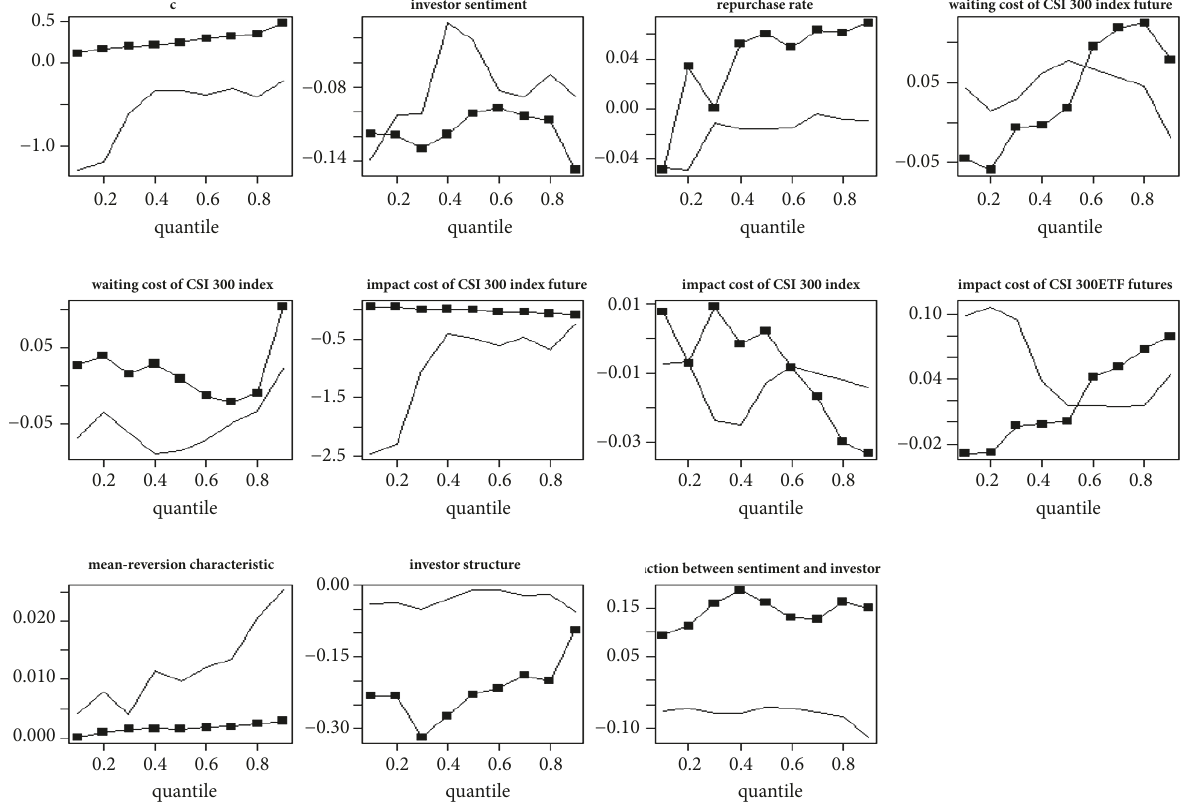
Figure 1: Changes of the quantile regression coefficients of the influence factors of the basis. Note: the solid line with square dots represents the quantile regression results in the chaotic stock market, and the solid line without dots shows the quantile regression results in the steady market.The abscissa axis and the ordinateaxes representthe different quantiles of thebasis and the regression coefficientsof various variables,